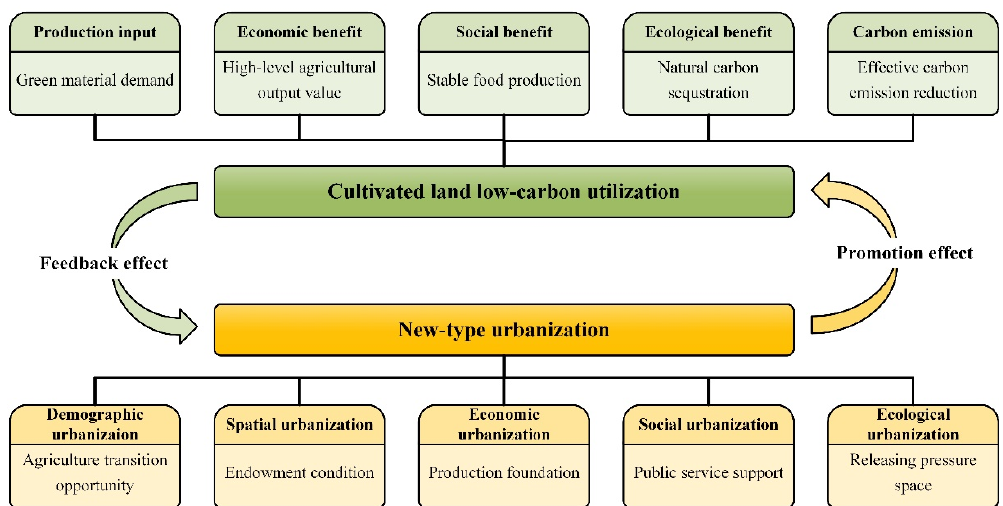
Figure 1. Mechanism of coupling coordination development between new-type urbanization and CLLCU.